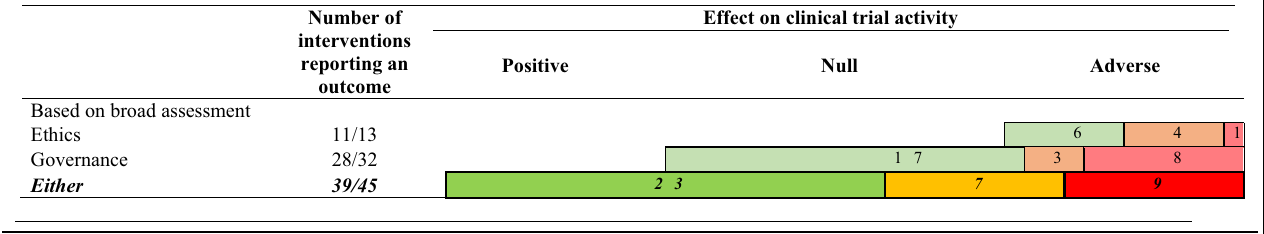
Table 3 Impact of ethics review and governance process interventions on clinical trial activity a